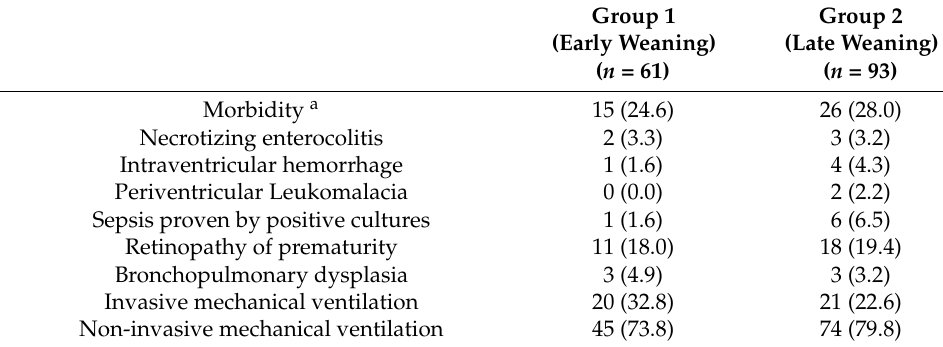
Table legend. a Intramuscular steroid cycle in two doses of 12 mg over a 24-h period; CRIB (clinical risk index for babies); PMA (postmenstrual age). Data are shown as mean (95% confidence inter- val) when not specified.